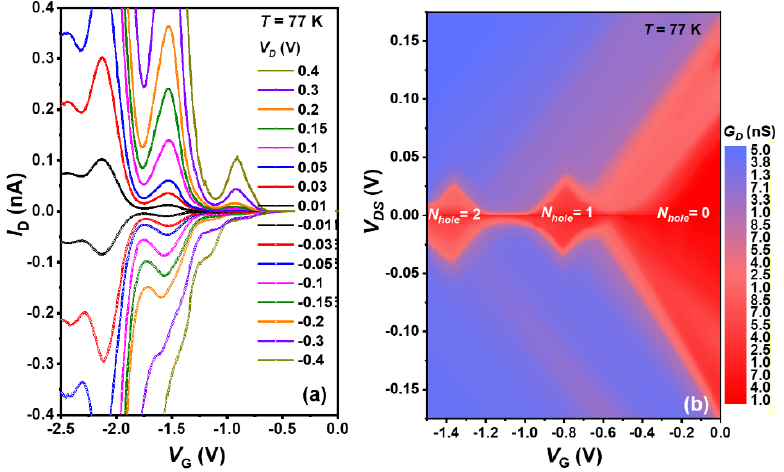
Figure 9. ( a ) I D -V D -V G curves and ( b ) Coulomb stability diagram of Ge-QD SHTs measured at T = 77 K.